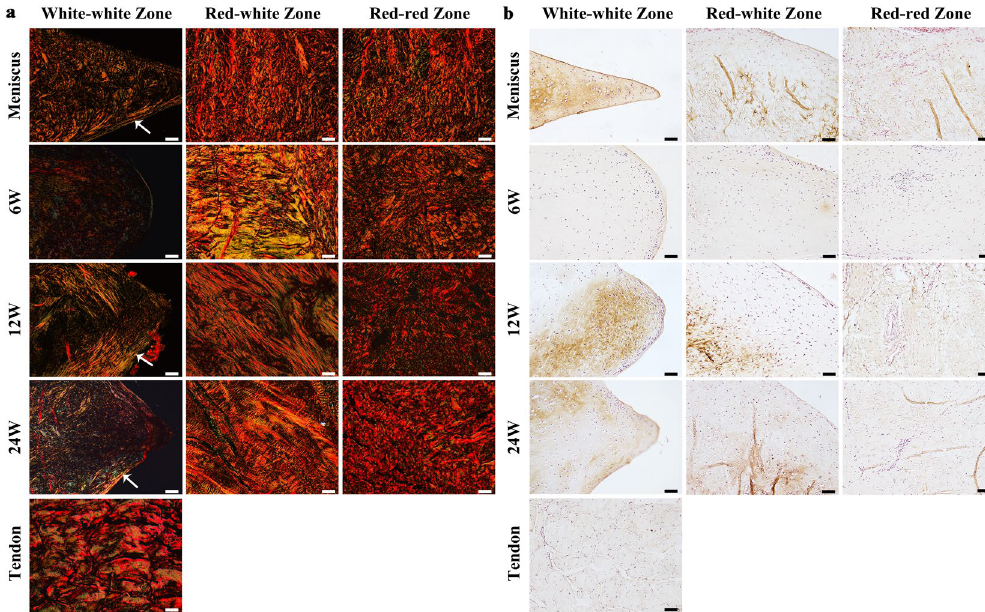
Figure 6. Picrosirius red and immunohistochemistry staining of collagen II of native meniscus, native tendon and regenerated meniscus at 6, 12 and 24 weeks post-operation of transplantation group in white-white zone, red-white zone and red-red zone. ( a ) Picrosirius red staining, with collagen type I stained red and collagen type III stained green. (white arrow, Radial collagen I fibers). Scale bar = 100 μ m. ( b ) Immunohistochemistry staining of collagen II. Scale bar = 50 μ